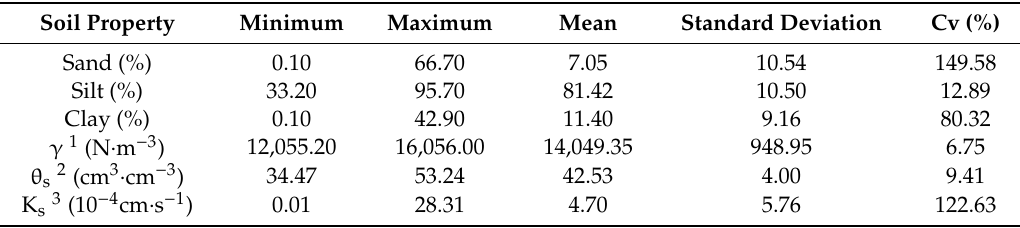
Table 2. Basic statistical characteristic values of soil